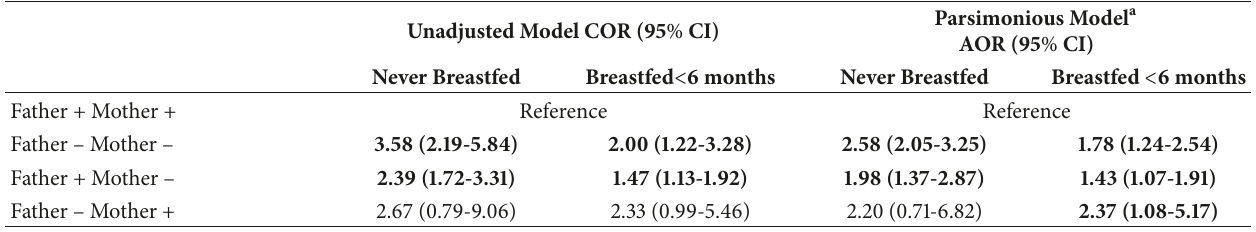
Table 3: Association between couple pregnancy intention and breastfeeding duration: NSFG